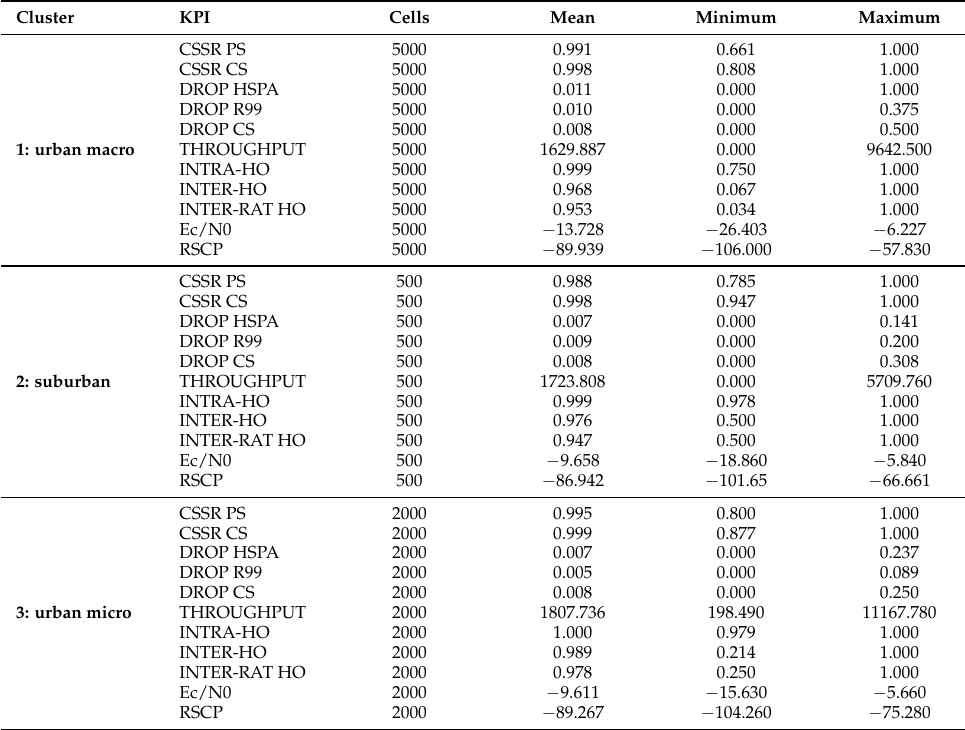
Table A1. Statistics of variables (KPIs) according to